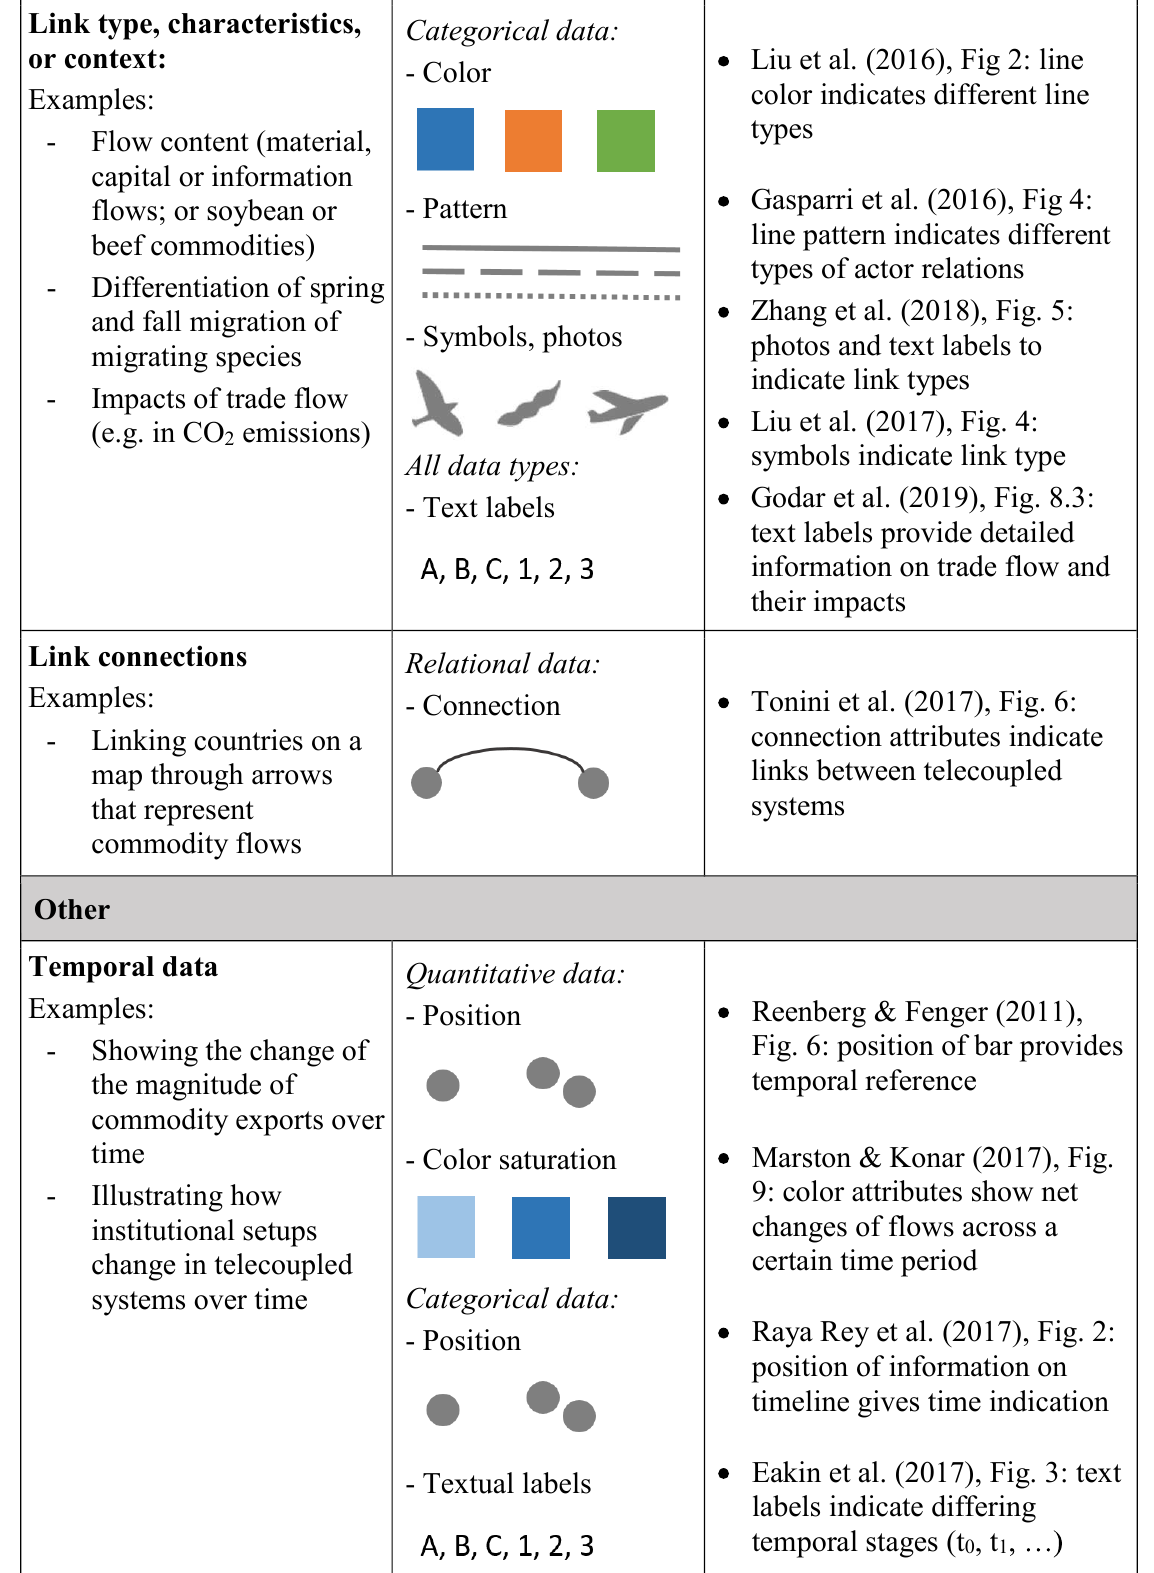
Figure A3.1 . Visual attributes in telecoupling